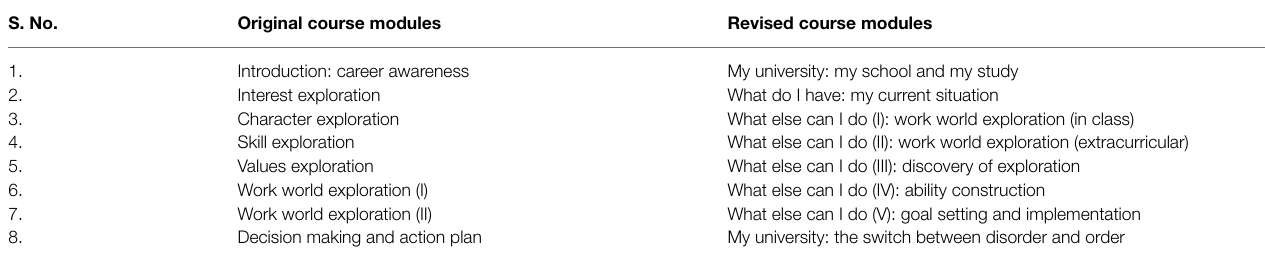
TABLE 5 | Curriculum adjustment of college career education. S.